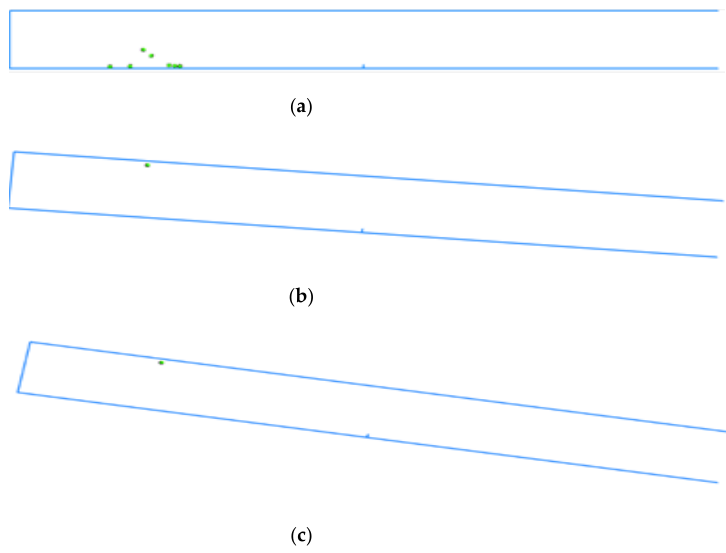
Figure 10. The different inclination angles of drainage pipes. ( a ) tilt angle 0°. ( b ) tilt angle 5°. ( c ) tilt angle 10°.